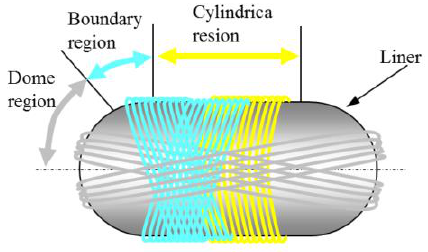
Figure 16. Synopsis of the first two layers of the 𝐻 2 tank [41].